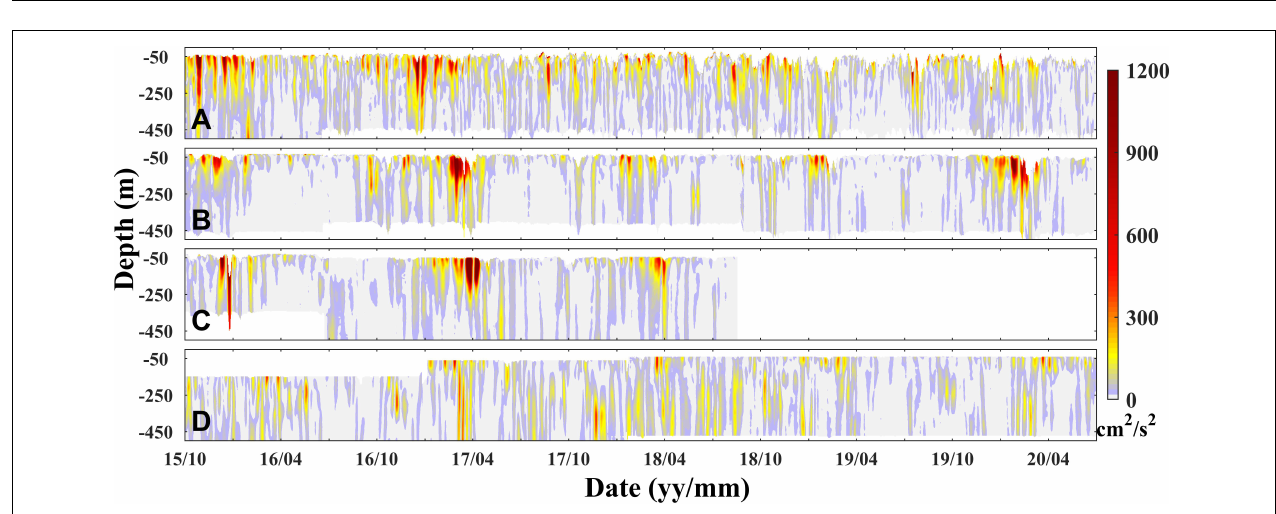
FIGURE 4 | Kinetic energy spectra (cm 2 /s 2 ) in variance-preserving form. Station (A) LS01, (B) DS01, (C) DS02, and (D) XS01. XS01 spectrum was calculated from 3.5 years of data (January 2017 to July 2020).